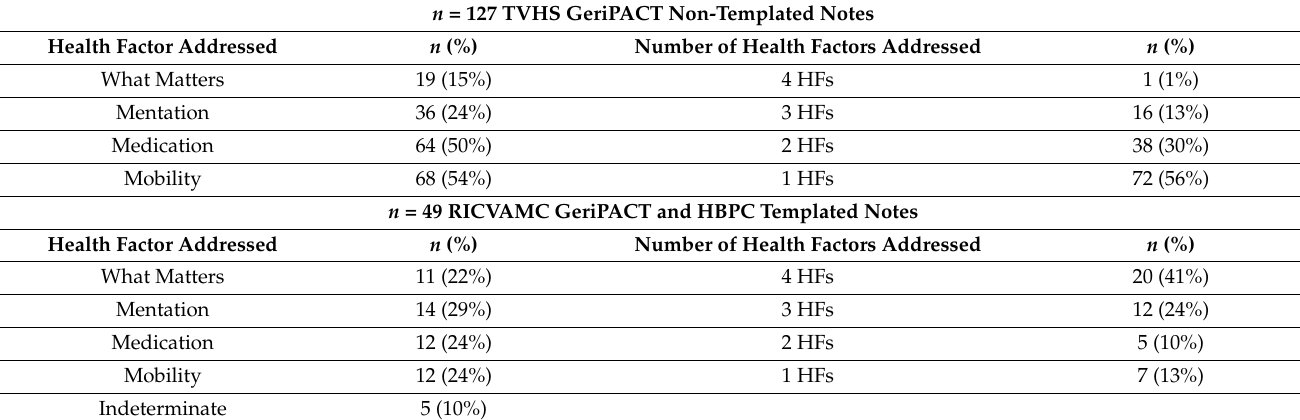
Table 2. Addressing age-friendly health factors in outpatient care.